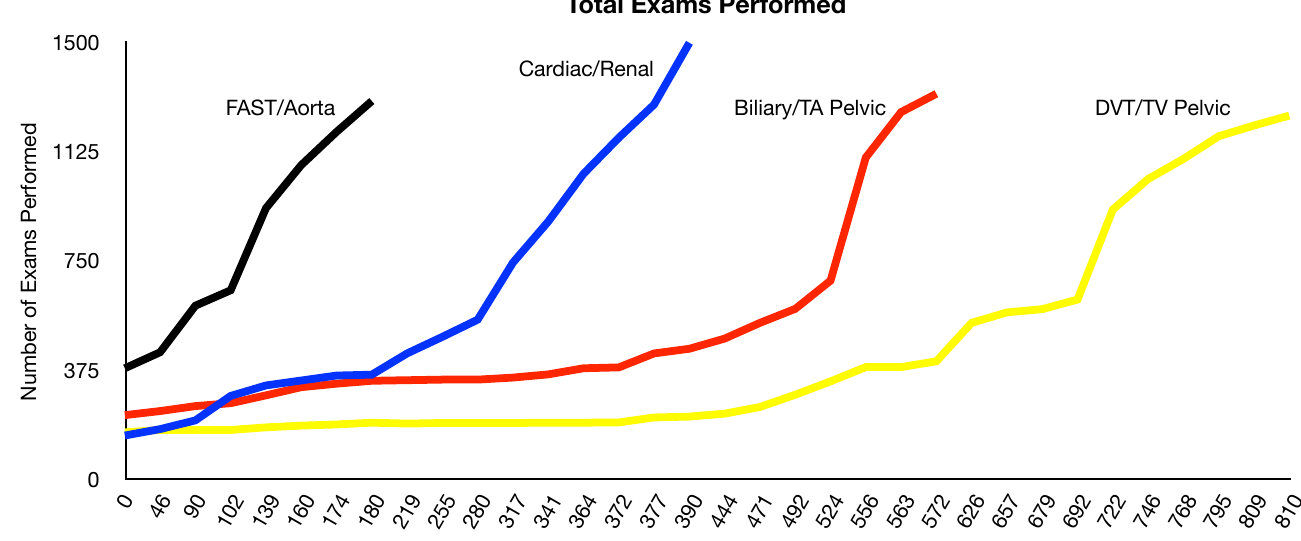
Figure. Total numbers of ultrasound exams performed since initiation of the training